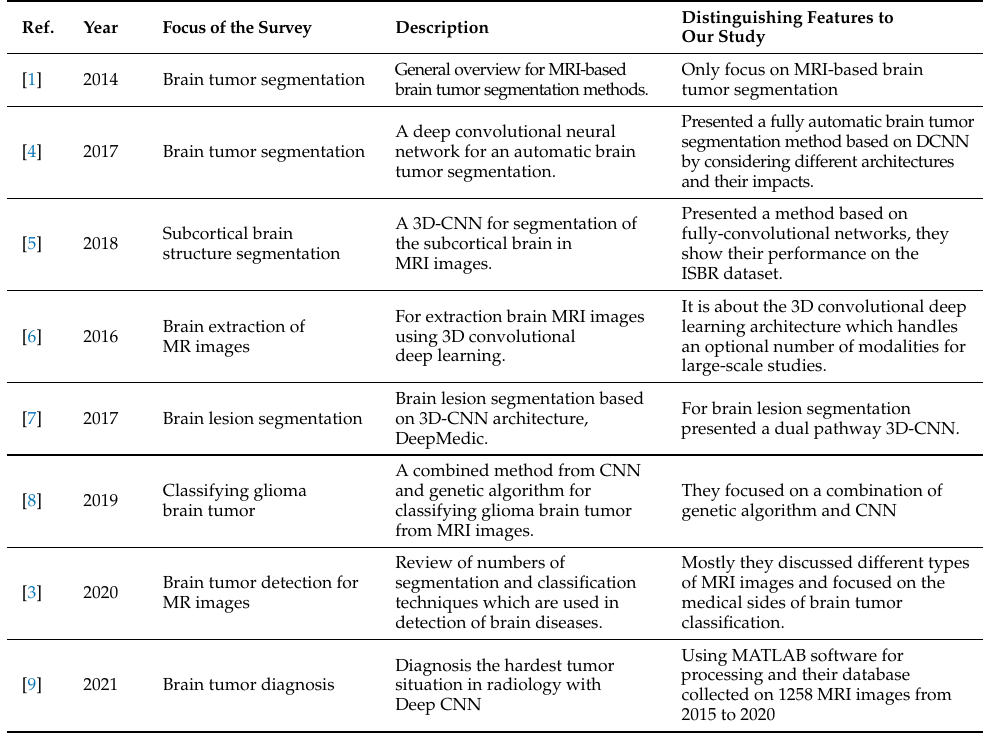
Table 1. List of the existing related surveys to this study.